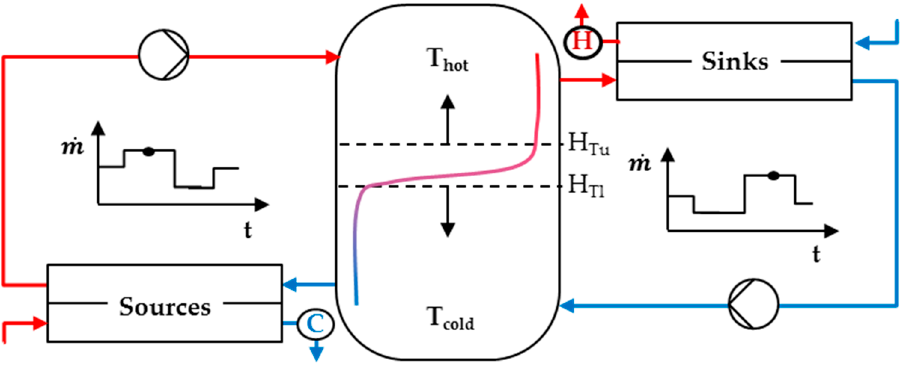
Figure 1. Heat recovery loop (HRL) based on a stratified tank (ST) and thermocline control.